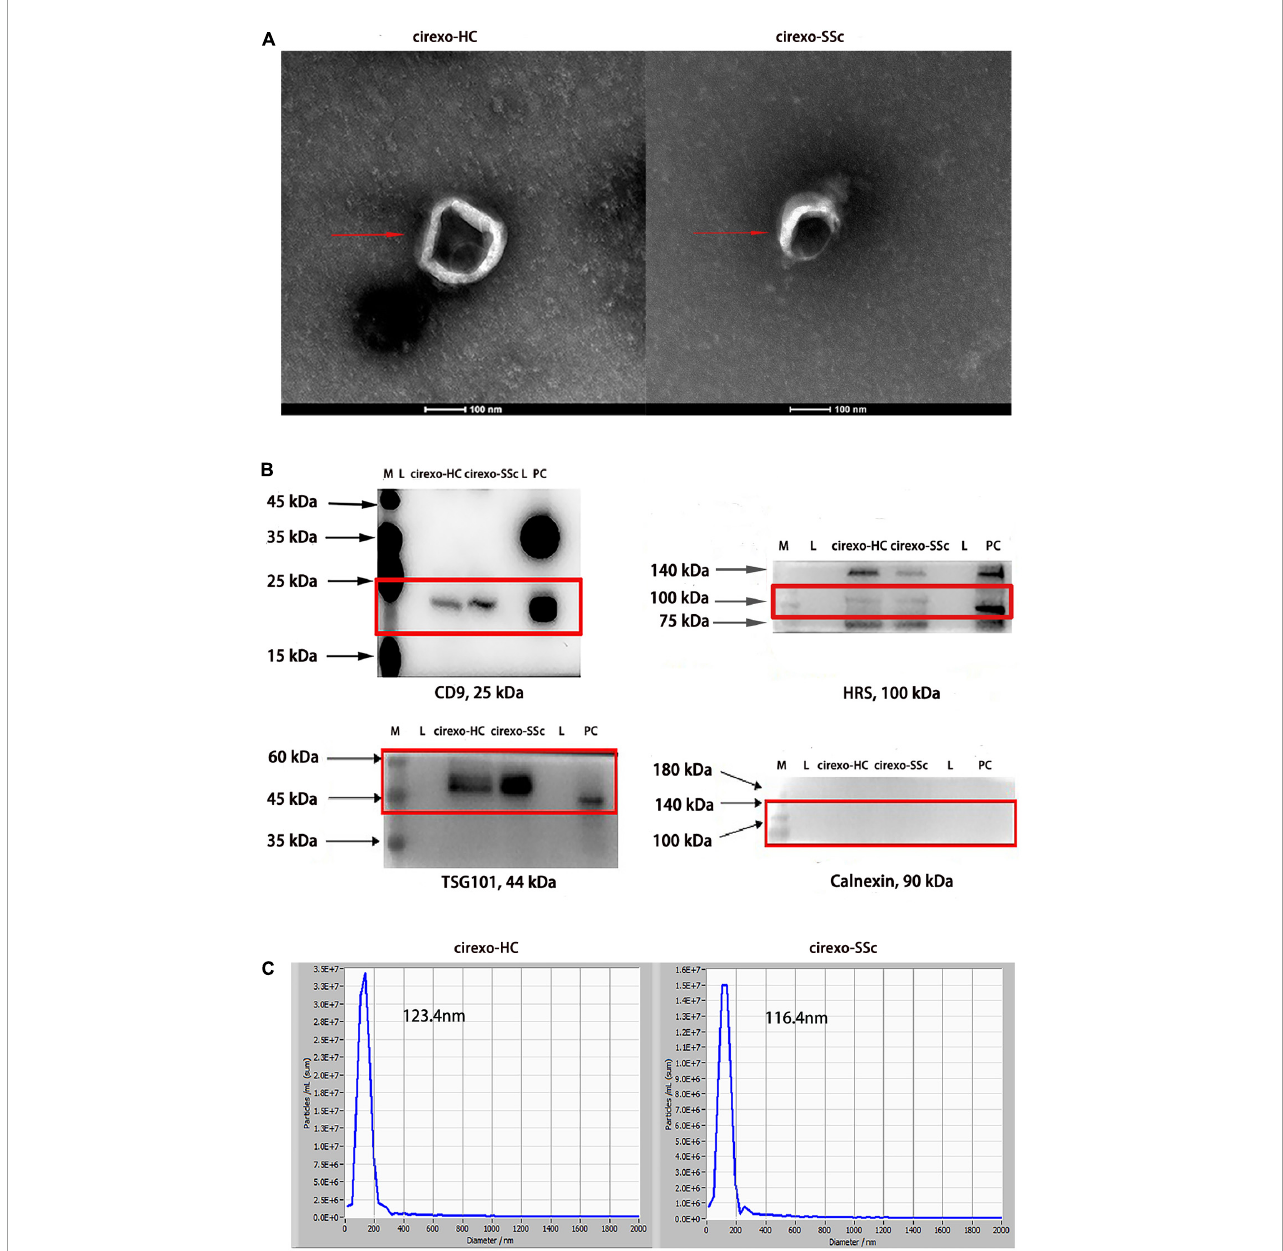
FIGURE2 Identification of circulating exosomes (cirexos). (A) The morphology of cirexos was detected by transmission electron microscopy (TEM) (magnification: 300,000 × ). (B) Identification of cirexo surface markers by western blot (WB). M, marker; L, loading buffer; PC, exosomes (EXOs) derived from